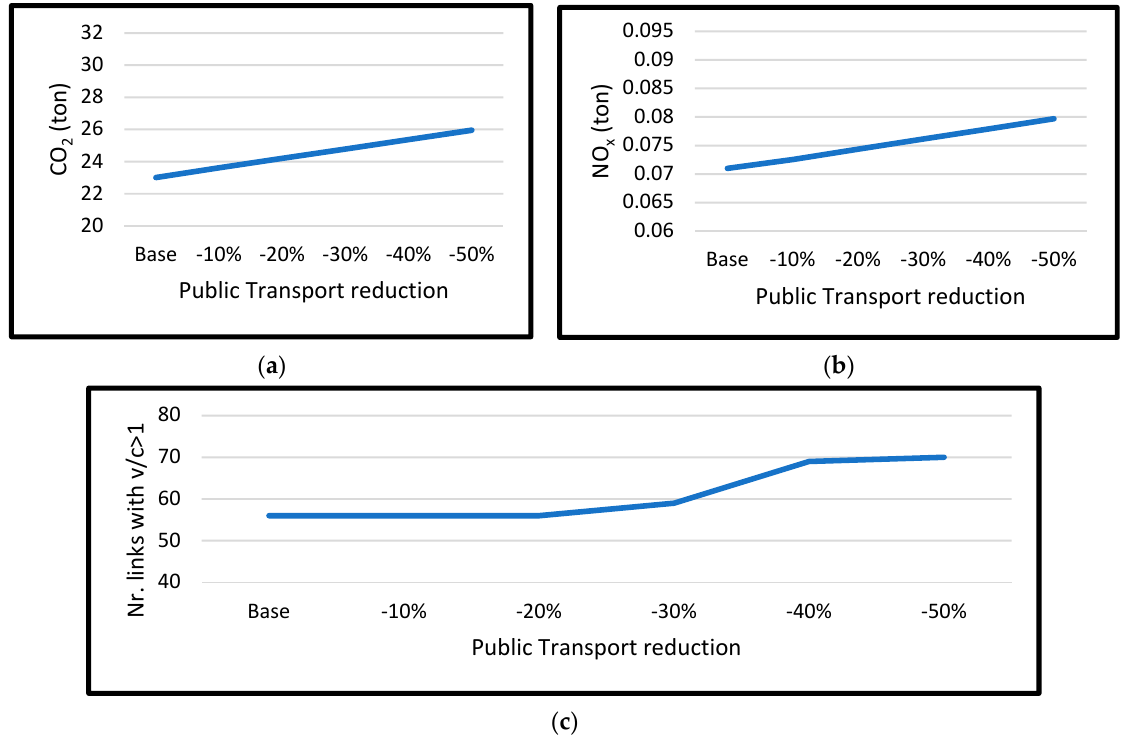
Figure 4. Results regarding scenario (1): ( a ) CO 2 ton; ( b ) NO x ton, and ( c ) number of links with a V/C ratio greater than 1. Peak-hour period.